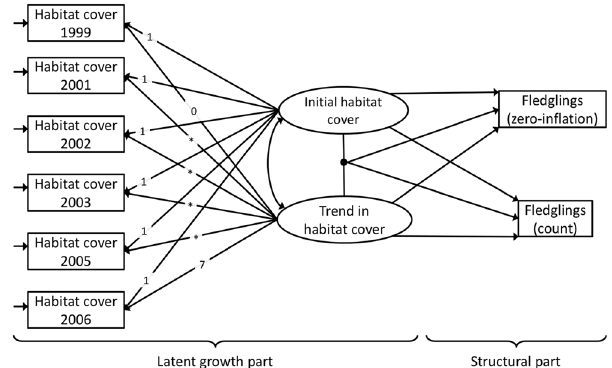
Figure 1. Graphical representation of baseline latent growth curve models used to examine the influence of change in habitat cover, initial habitat cover and their interaction on the cumulative number of fledged offspring at the end of the study period. The boxes on the left represent observed habitat data collected from individual years from which initial habitat cover and change in habitat cover, as well as their interaction are derived from. Single-headed arrows in the latent growth curve part of the model (on the left side) represent factor loadings, connecting the observed annual habitat cover and unobserved latent intercept and slope factors. Numbers along these arrows mean fixed values, while asterisks denote estimated values from the data. Single-headed arrows in the structural part of the model (on the right side) represent structural path coefficients examining how intercept and slope factors and their interaction influence cumulative fledgling number. The arrows originating from the connecting dot between initial habitat cover and change in habitat cover represent latent interactions between the latent factors. Covariance between initial habitat cover and change in habitat cover is depicted as a double-headed arrow. Short arrows pointing at the habitat variables represent their residual variances. Please note that these baseline models excluded residual covariances between habitat cover that we included in final